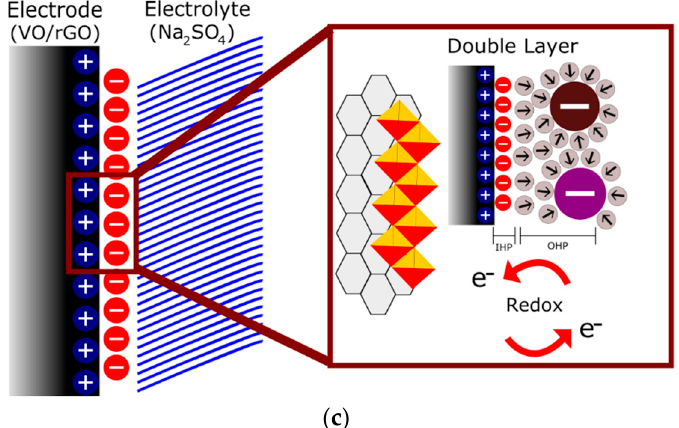
Figure 6. ( a ) Nyquist plots; ( b ) phase behavior with equivalent circuits; and ( c ) electrode/electrolyte interfacial schematic.